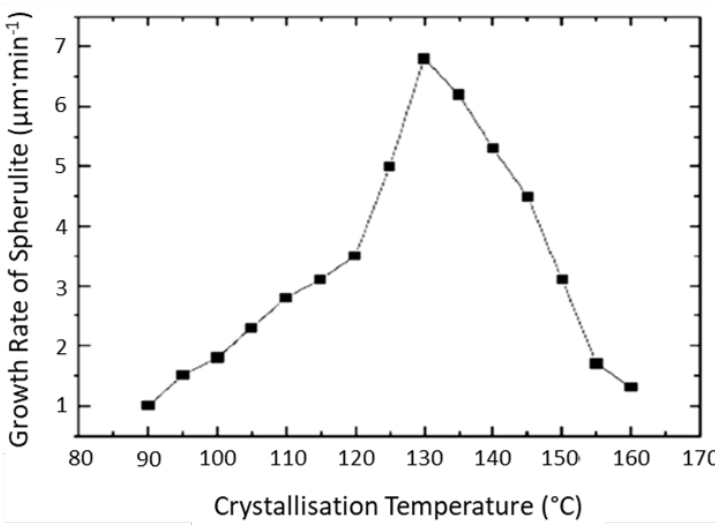
Figure 2. Spherulite growth rates of Poly- L -lactic acid (PLLA), isothermal crystallisation after cooling from the melt as a function of temperature [24] under open access license.